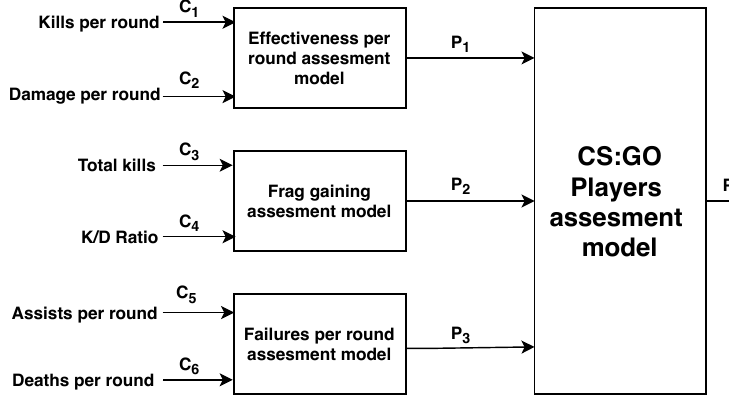
Figure 3. The hierarchical structure of the players ranking assessment